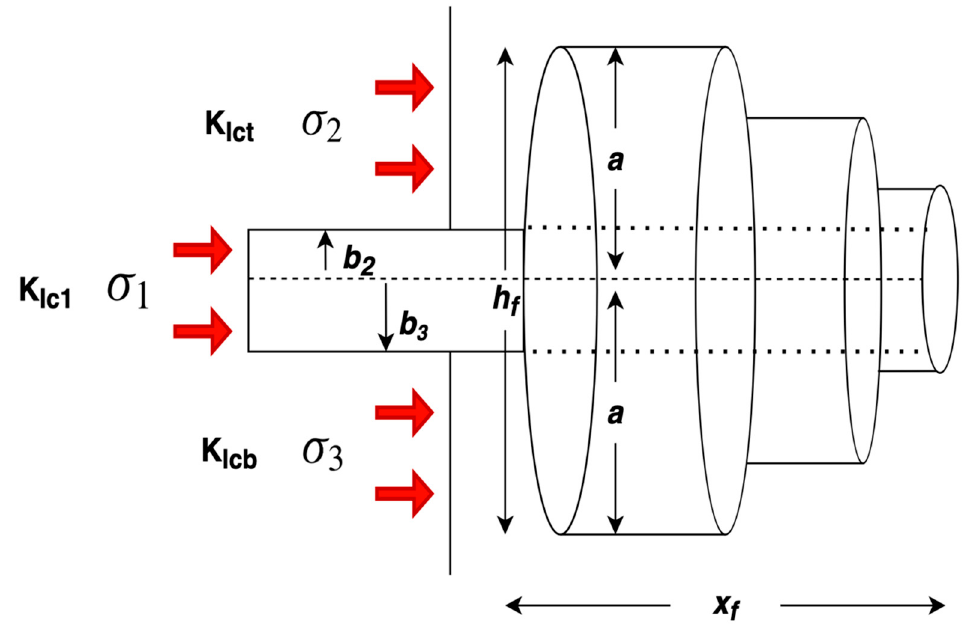
Figure 1. The Pseudo 3D fracture propagation model.